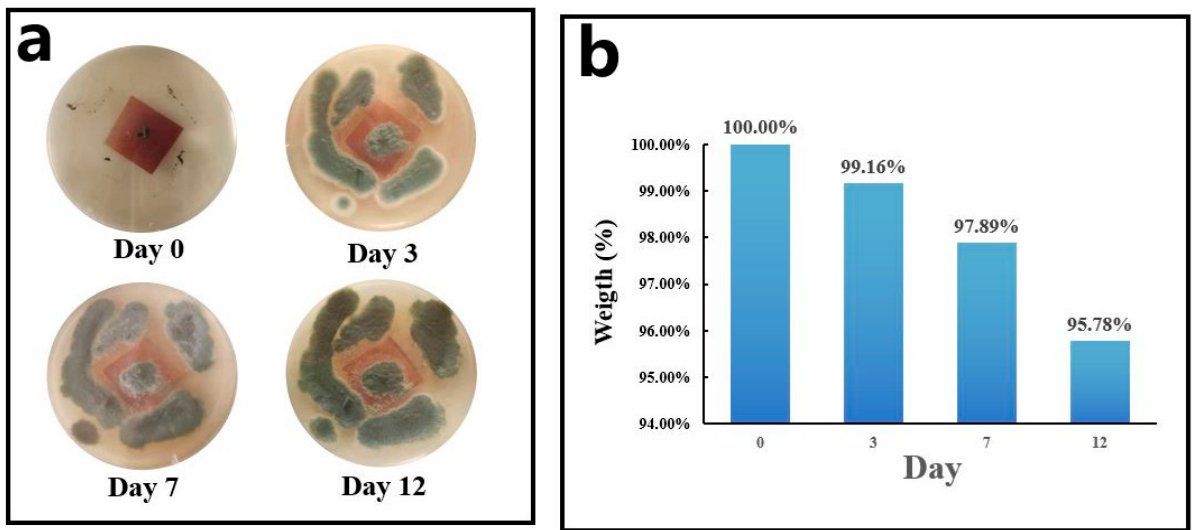
Figure 8. Biodegradation process of the TLP film, ( a ) Penicillium sp. movement in 12 days, ( b ) Mass loss of TLP film within 12 days.